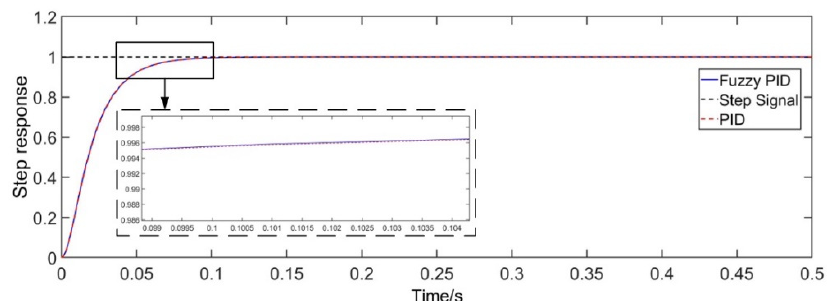
Figure 6. Control system step response graphs.